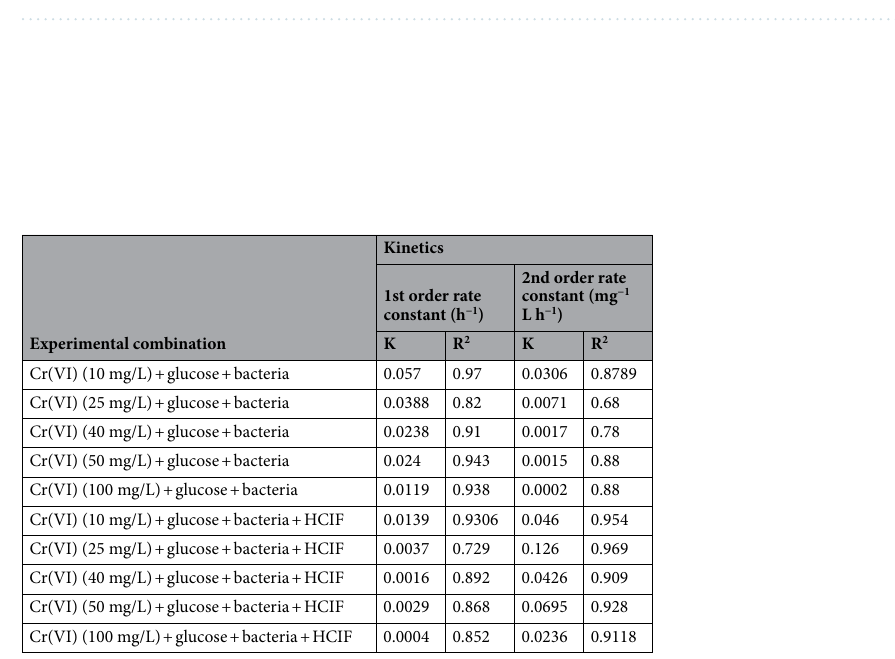
Figure 3. Comparison of glucose concentration with respect to time ( A ) in single substrate system ( B ) in multiple substrate system.